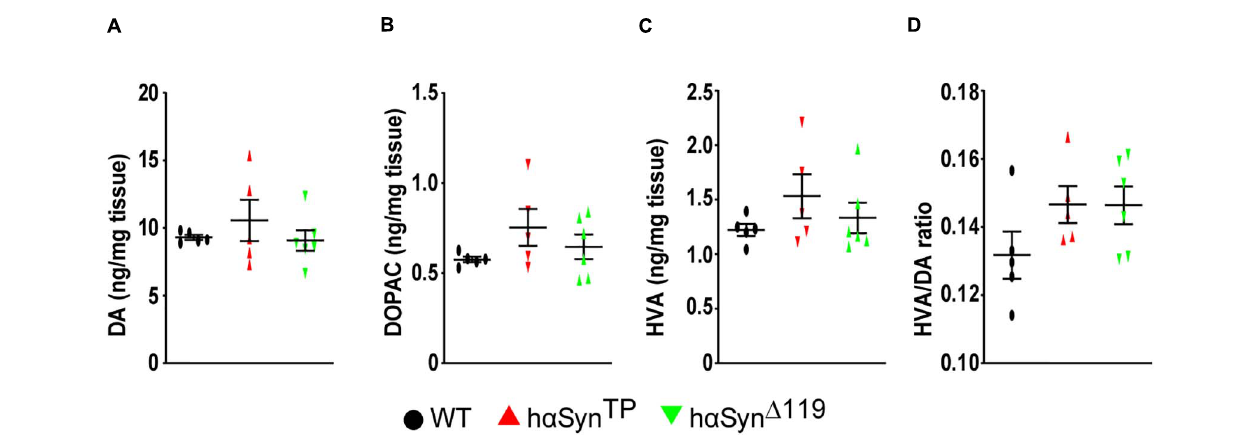
FIGURE 3 | Increased variability of the concentration of dopamine and its metabolites in the striatum of h α Syn TP and h α Syn (cid:49) 119 mice at 1.5 years of age. (A–C) DA, DOPAC, and HVA content varied considerably within h α Syn TP or h α Syn (cid:49) 119 , but not within WT mice. (D) h α Syn TP and h α Syn (cid:49) 119 mice showed increased HVA/DA ratio compared to WT, although not statistically significant. For all instances, n ≥ 5 mice per group. Represented in graph are individual values and group means ± SEM. Group comparisons using 1-way ANOVA with Bonferroni’s multiple comparisons test for mean differences and Bartlett’s test for SDs